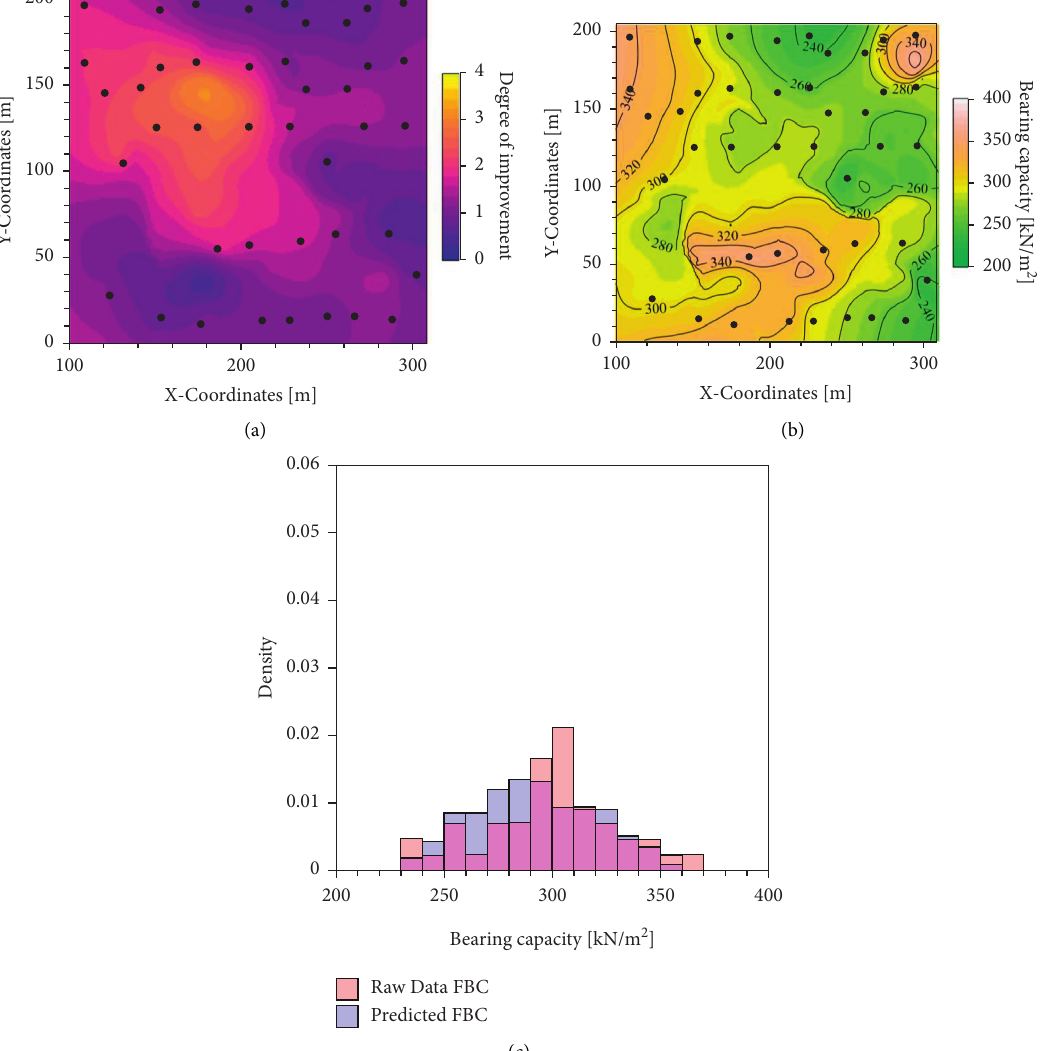
Figure 12: Results from ANN model: (a) exhaustive map for the degree of improvement (DI) due to dynamic compaction interpolated using ANN model, (b) Bearing capacity after dynamic compaction deduced from predicted degree of ground improvement, and (c) PDF plots of ANN generated bearing capacities after DC overlaid with PDF of the raw data of bearing capacities after DC. Note . The location of the SPT-N boreholes after DC is indicated with black circular